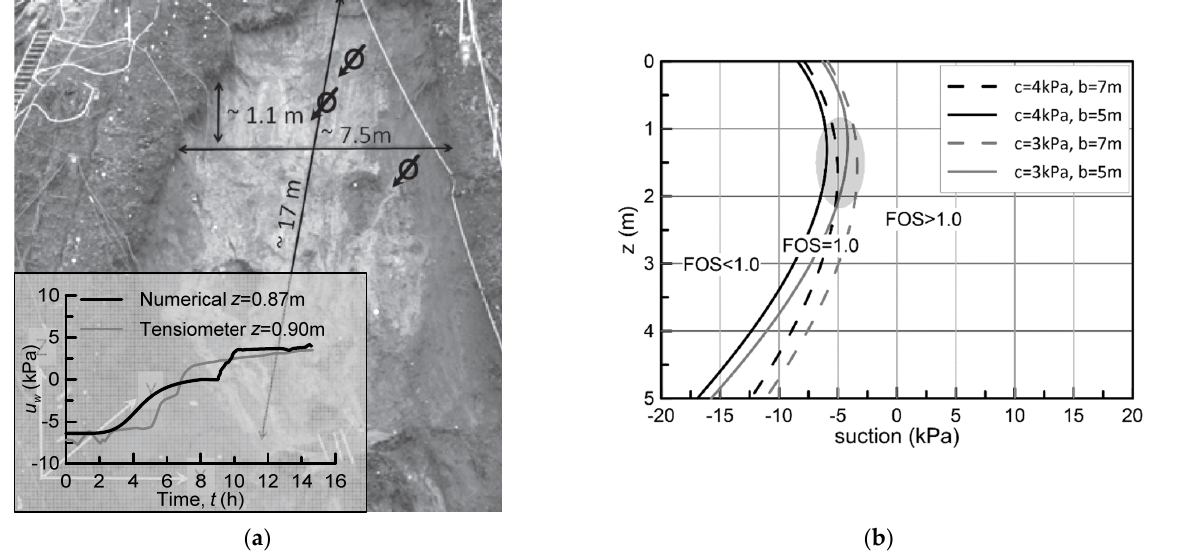
Figure 11. ( a ) The Ruedlingen slope failure (after [1]) and the evolution of pore water pressure in the slope mass (after [9]); ( b ) stability curves for different combinations of cohesion and slope widths which can accurately capture the observed instability (grey shaded area).